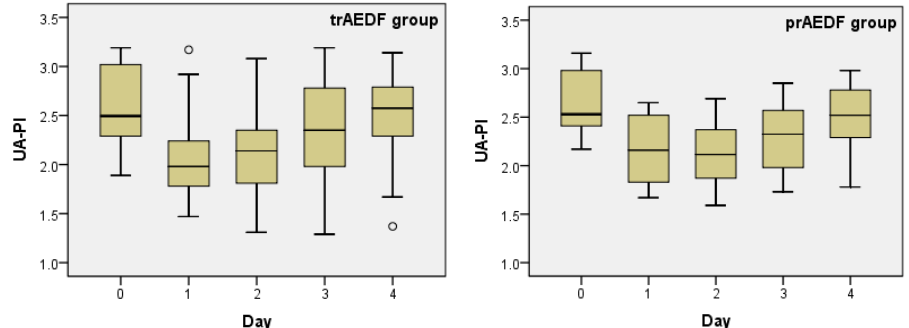
Figure 1. Boxplot charts on the pulsatility index’s evolution in the umbilical artery (UA-PI), prior (day 0) and in the first 4 days after maternal dexamethasone administration, in the two groups (tr/prAEDF = transiently restored/persistent absent end-diastolic flow in umbilical artery group). Until delivery, in total, five cases (50%) belonging to the prAEDF group and in three (13.6%) cases from the trAEDF group, respectively, the Doppler worsened, with the oc ‐ currence of REDF in UA and/or absent A ‐ wave in DV, imposing fetal extraction. The dif ‐ ference was statistically significant (OR: 6.3; p = 0.037).